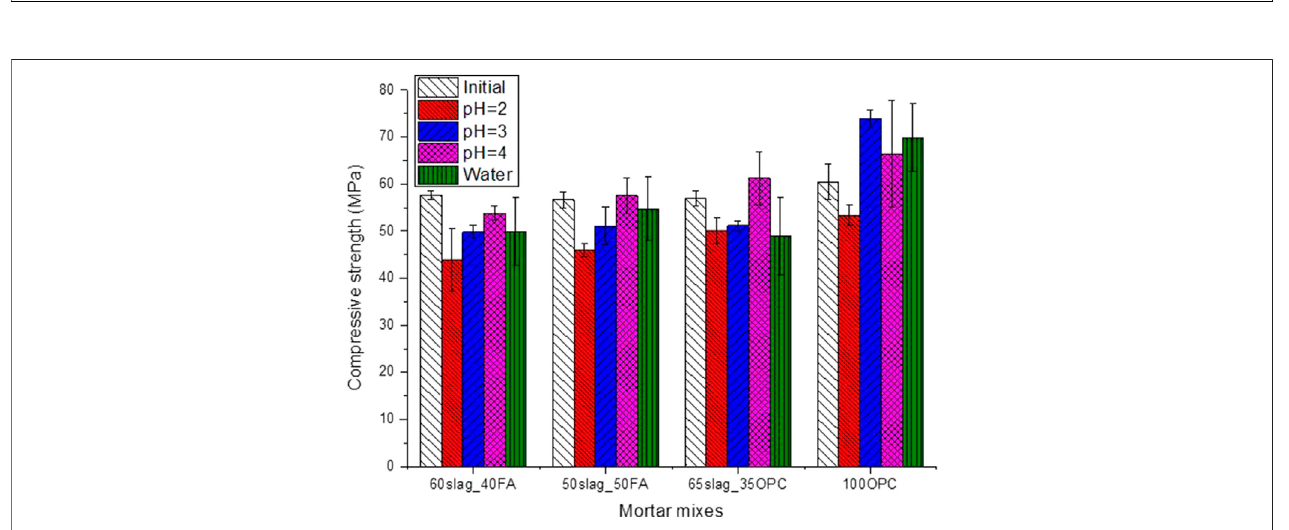
FIGURE6 | Compressivestrength of thefour mortar mixes after 150-day exposureinphosphoric acid solutions withdifferentpH values and in water asreference.